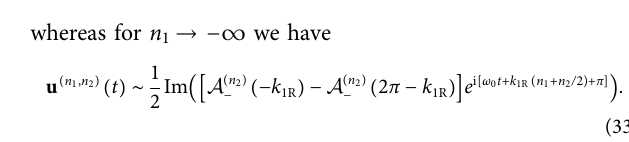
FIGURE 3 | Dispersion diagram for k 1 ∈ [− 2 π , 2 π ] , relevant for Eq. 23 when n 2 is odd. The black (gray) curve indicates the function ω R for Ω * (cid:1) 1 ( Ω * (cid:1) 0). The line ω (cid:1) ω ω (cid:1) 0 . 6. The intersections of this line with the curve of ω 0 is shown for 0 relevant for Eq. 23 when